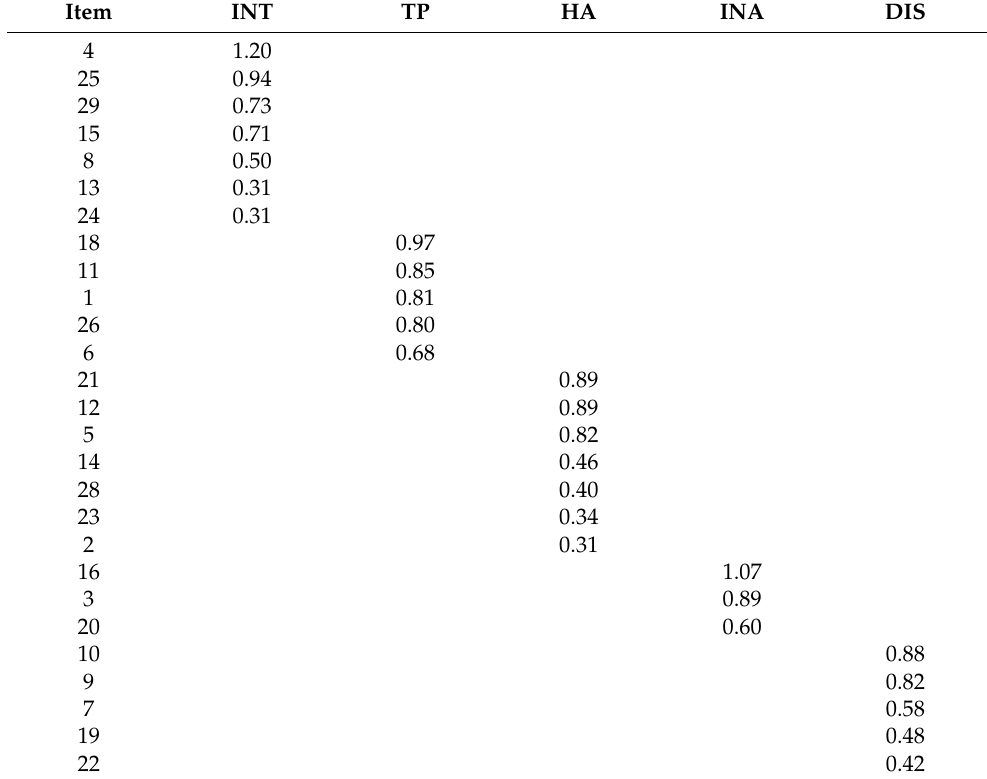
Table 3. Distribution of items and standardized saturations on their respective factors deriving from EFA of the five-factor model of the